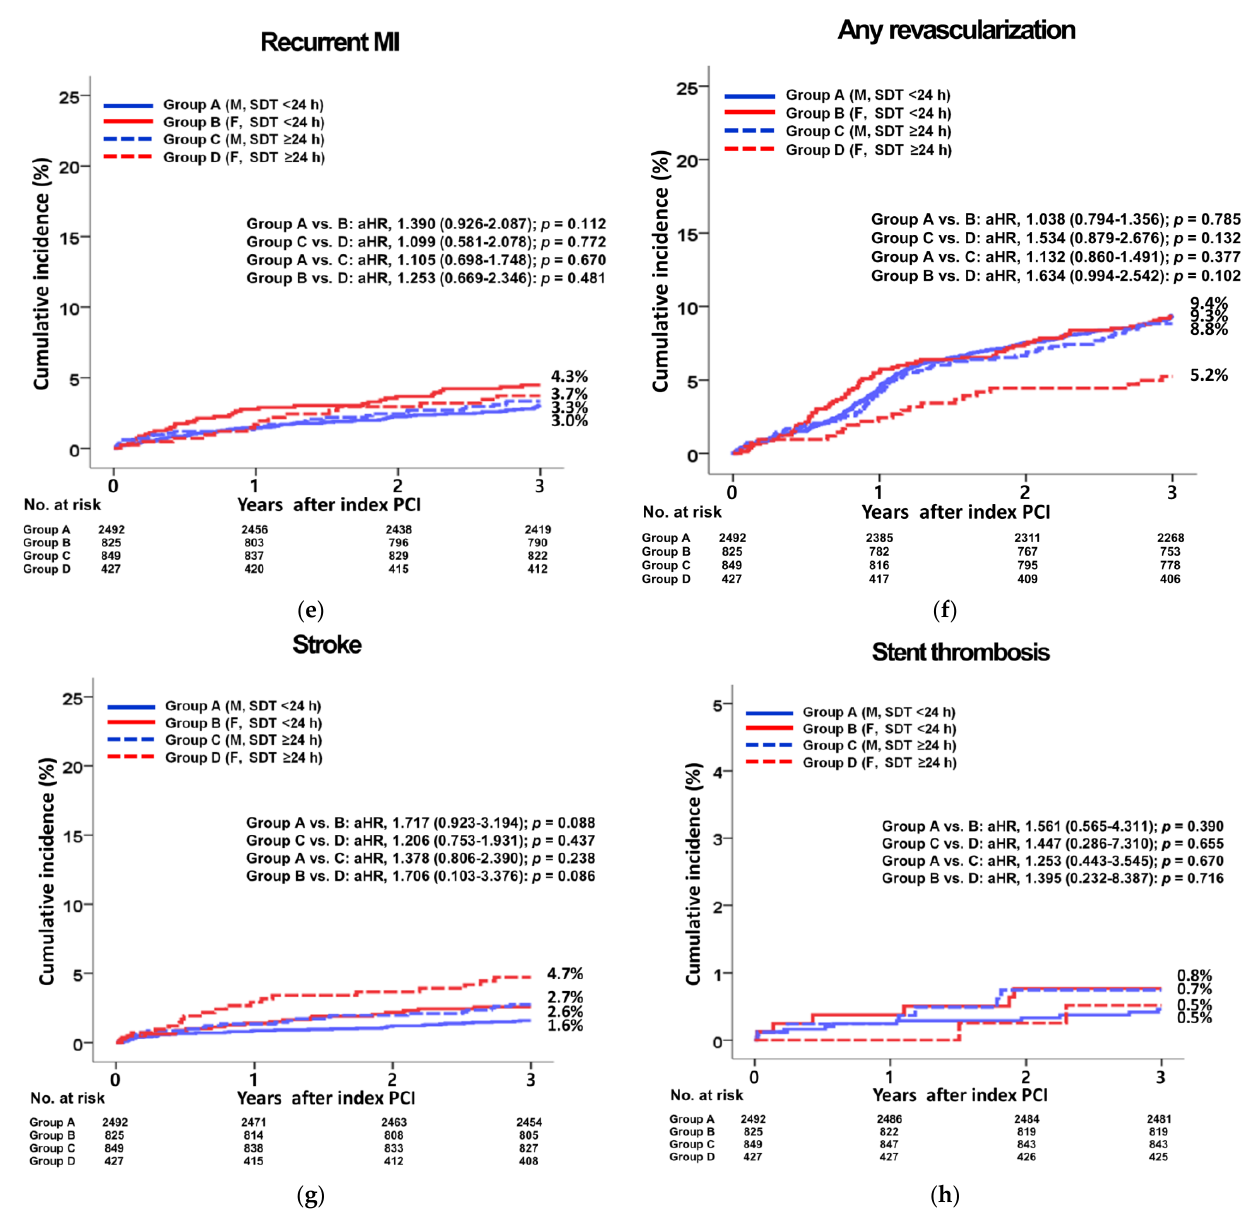
Figure 2. Kaplan – Meier curved analysis for MACCE ( a ), all-cause death ( b ), cardiac death ( c ), non-cardiac death ( d ), recurrent MI ( e ), any repeat revascularization ( f ), stroke ( g ), and stent thrombosis ( h ). MACCE, major adverse cardiac and cerebrovascular events; M, male; F, female; MACCE, major adverse cardiac and cerebrovascular events; M, male; F, female; SDT, symptom-to- SDT, symptom-to-door time; aHR, adjusted hazard ratio; CI, confidence interval; MI, myocardial infarction. door time; aHR, adjusted hazard ratio; CI, confidence interval; MI, myocardial